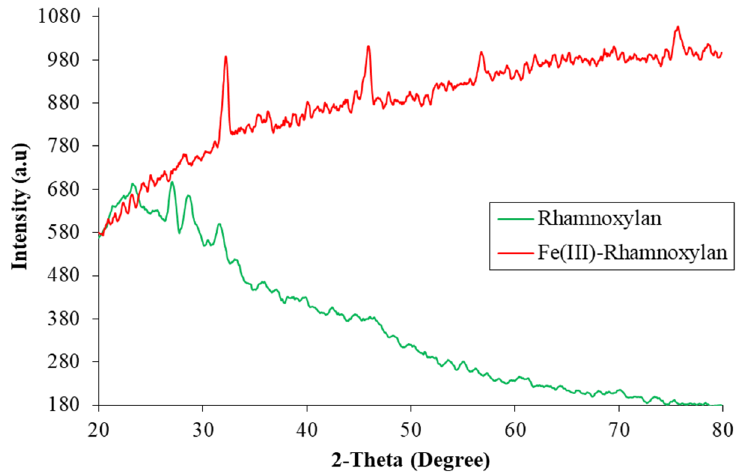
Figure 7. X ‐ ray diffraction patterns of rhamnoxylan and Fe(III) ‐ rhamnoxylan complex.